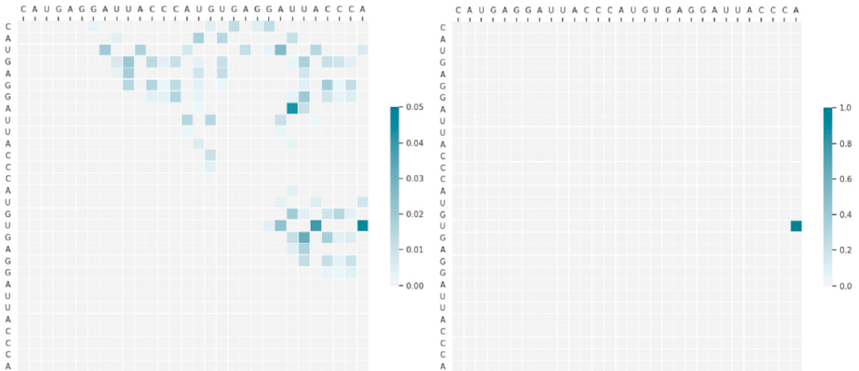
Figure 10. The action space probability matrix diagram of PDB_00972 ( left ) and the probability matrix diagram corrected by Monte Carlo tree search ( right ).